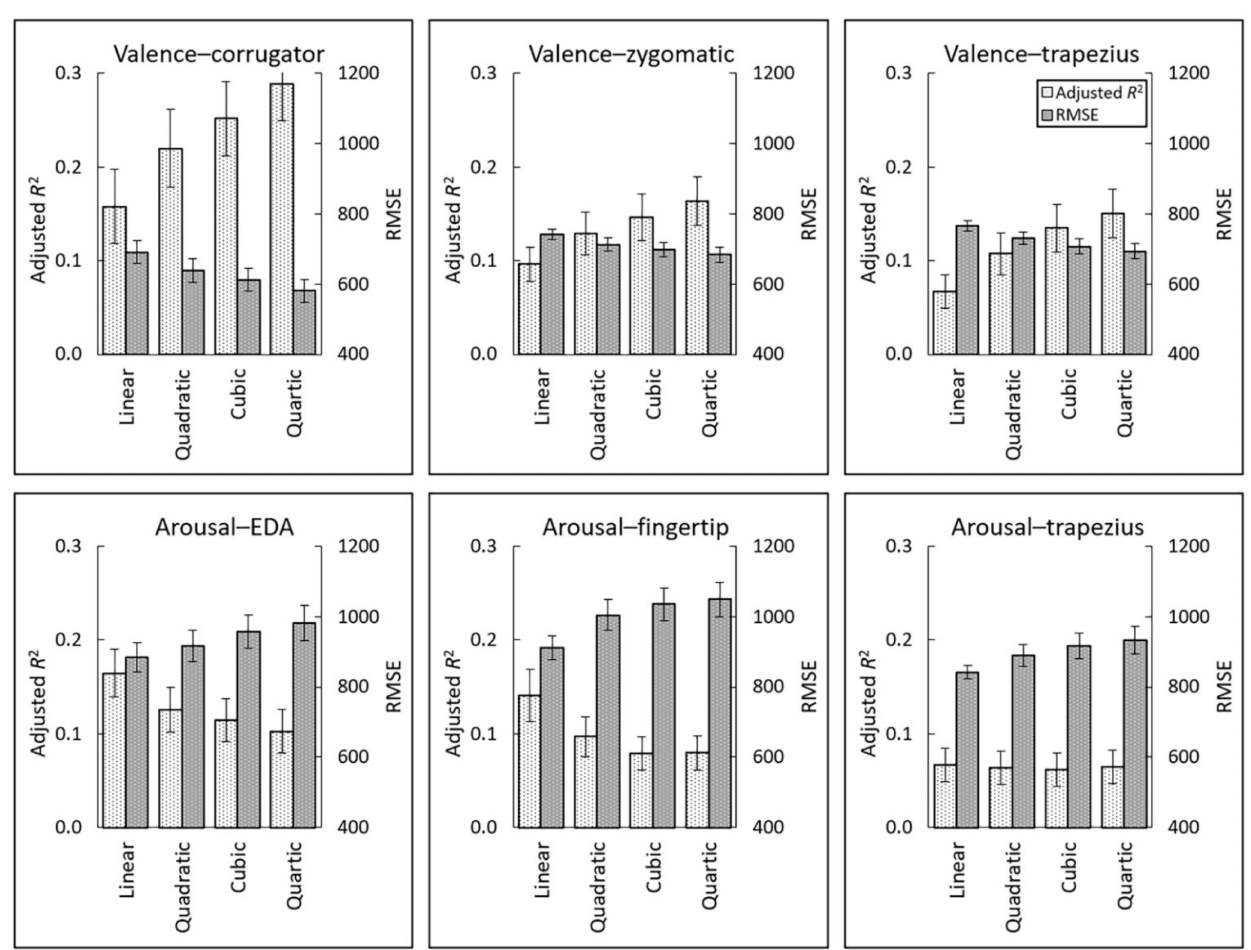
Figure 5. Mean ( ± standard error) adjusted R 2 and root mean squared error (RMSE) values of linear, quadratic, cubic, and quartic polynomial regression models of expected subjective–physiological concordance. EDA, electrodermal activity.